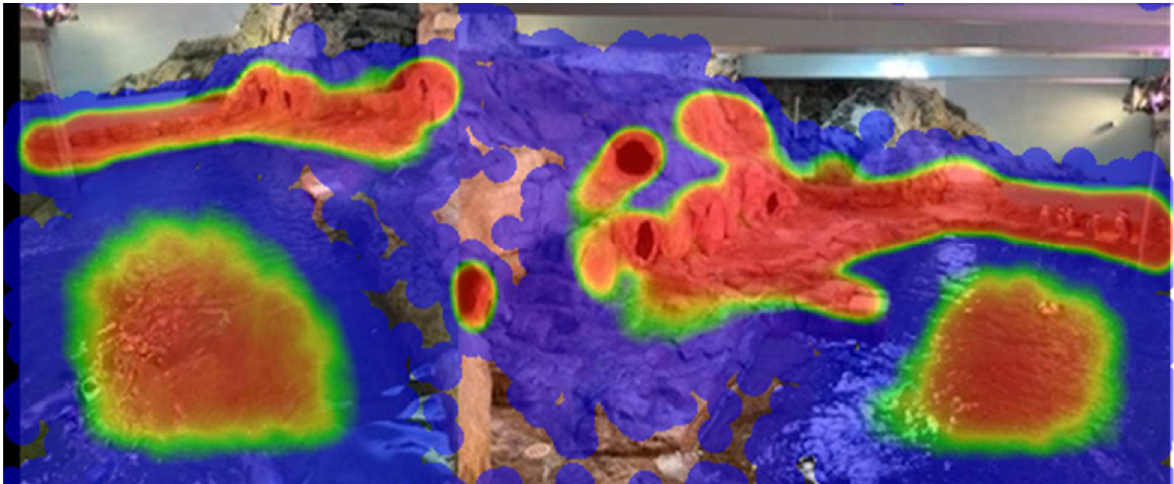
Figure 9. Combined heat map for all penguins over 146 observation days. Areas of intense use are shown in red; areas that were rarely used are shown in blue.